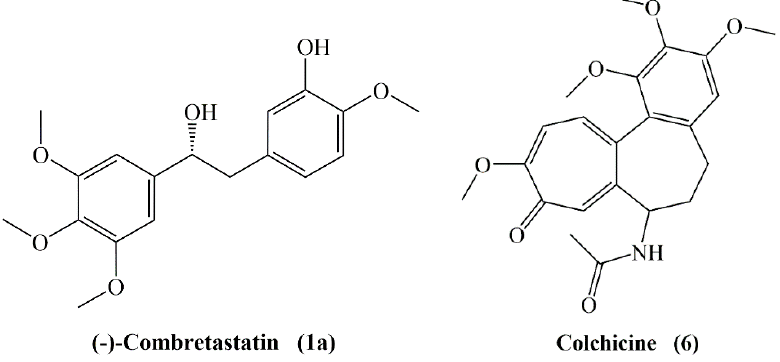
Figure 2. Structural similarity between combretastatin ( 1a ) and colchicine ( 6 )